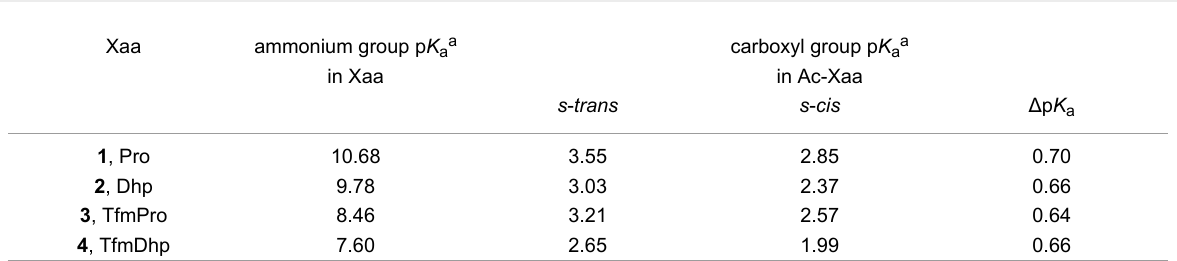
Table 1: p K a Values determined for the amino acids 1 – 4 and their N -acetyl derivatives.